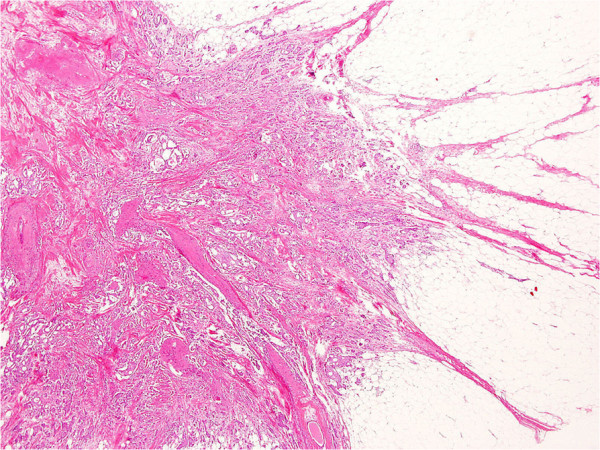
Representative histopathological specimens of the three subtypes of invasive ductal carcinoma–not otherwise specified. Invasive ductal carcinoma growing in a scirrhous manner (scirrhous carcinoma; SIDC) is characterized by cancer nests or cells accompanied by marked fibrosis
[4].